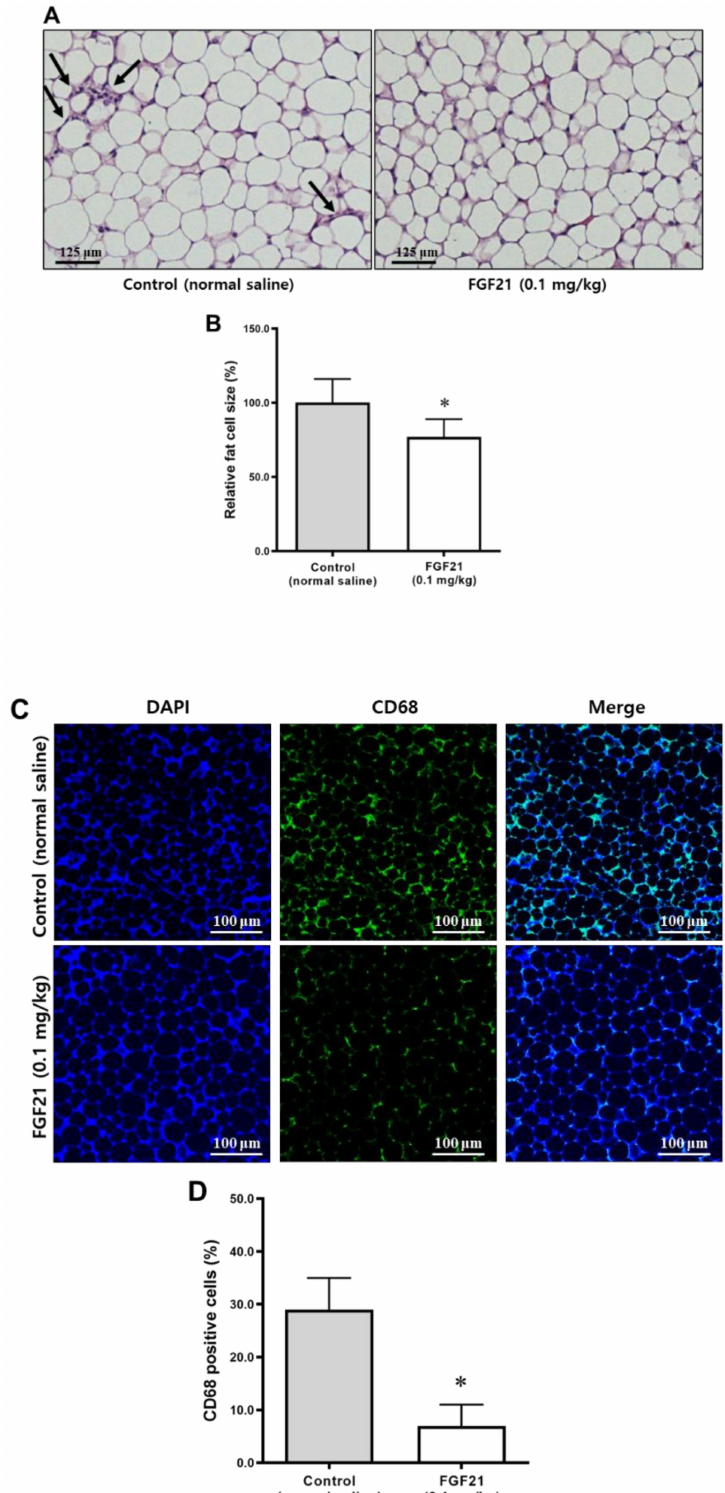
Figure 5. ( A ) Histology of abdominal visceral adipose tissues stained with H&E (scale bars, 20 µ m). The arrows indicate crown-like structures. ( B ) Comparison of fat cell size (% of control) between the control and the FGF21 groups. ( C ) Immunohistochemical staining of CD68 in the abdominal visceral adipose tissue (scale bars, 20 µ m). ( D ) CD68-positive cells were significantly less abundant in the FGF21-treated mice than in the controls (% of total cells). Data are means ± SD. * p < 0.05 vs.